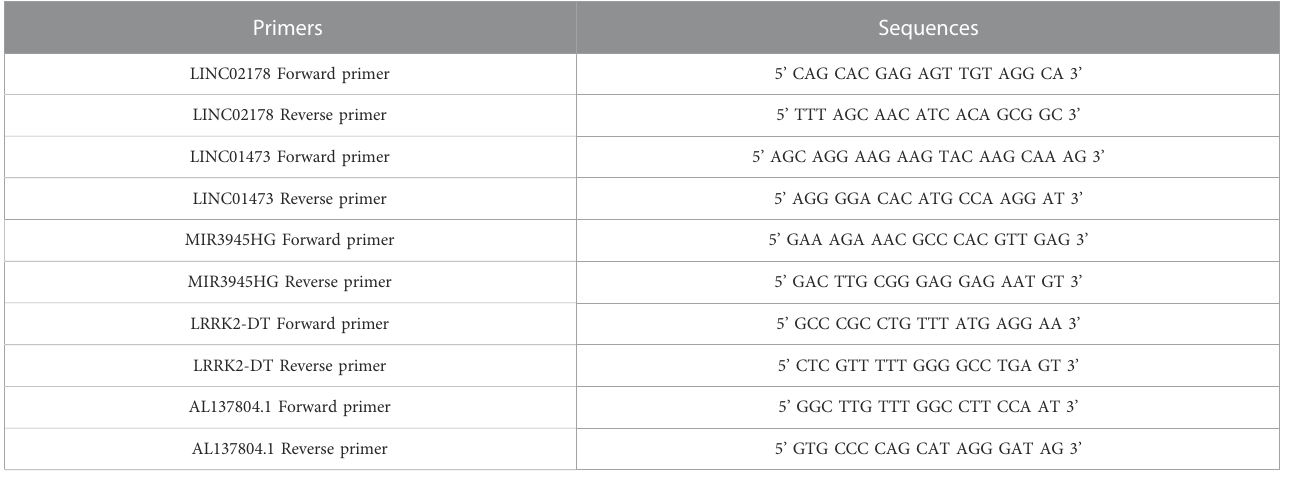
TABLE 1 The primer sequences for qRT-PCR.